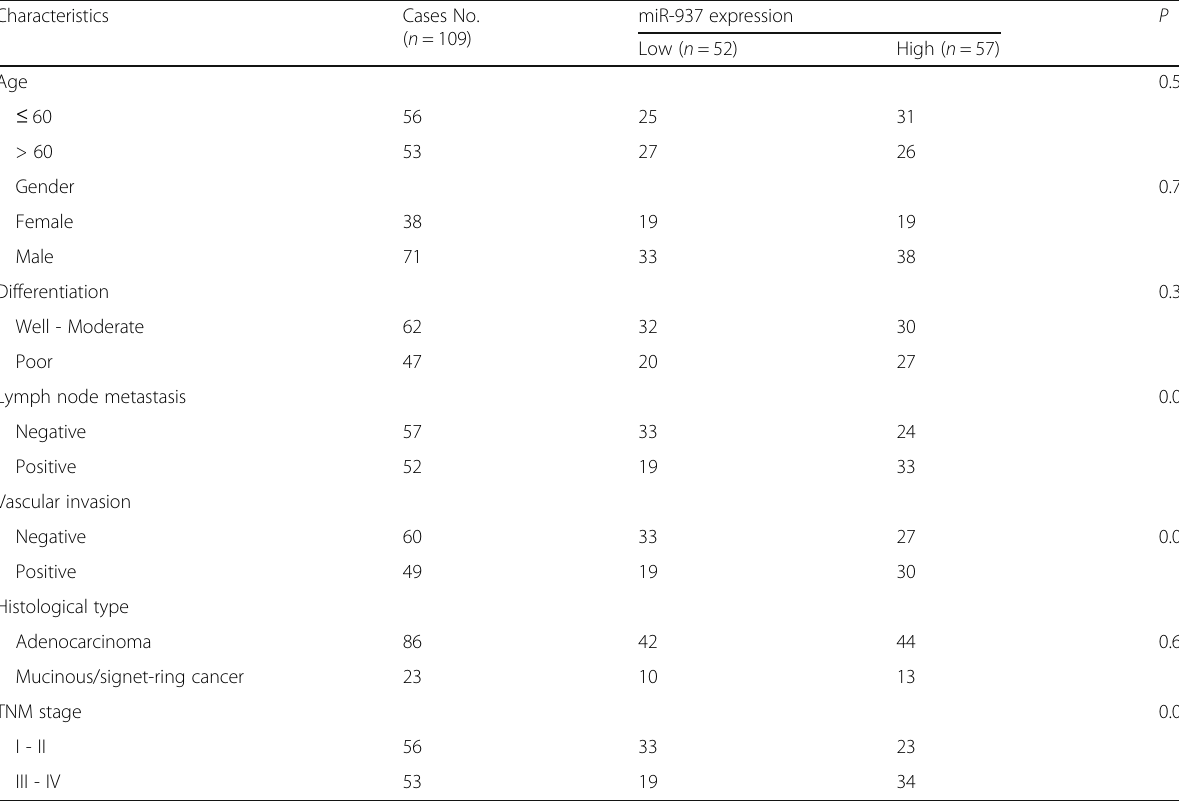
Table 1 Association of clinical characteristics of colon cancer patients and miR-937 expression